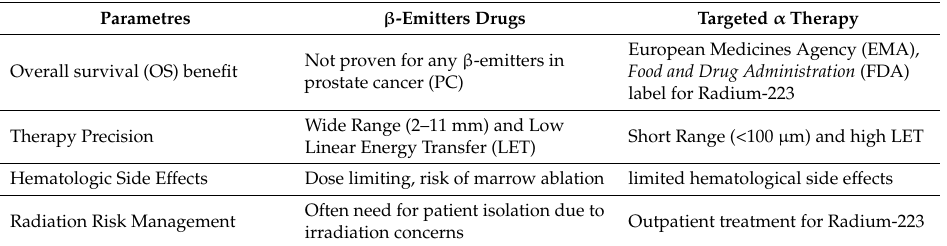
Table 1. Main differences between β -emitters radiopharmaceuticals and targeted α therapies.